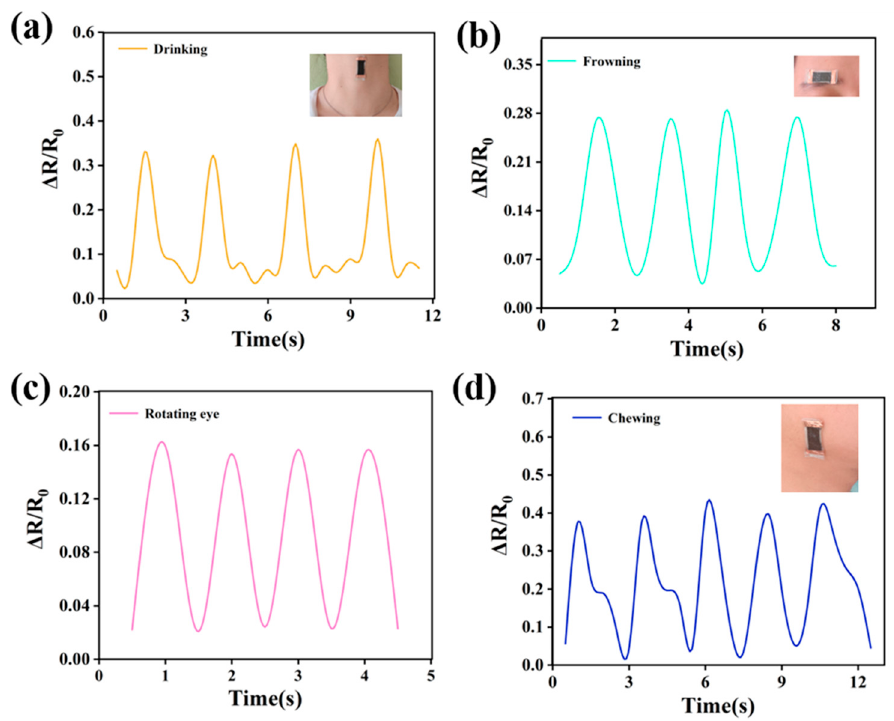
Figure 9. Applications of DEF/c-MWCNTs/PPy sensor in monitoring various subtle human motion: the RRV signal of DEF/c-MWCNTs/PPy warp sensor in monitoring ( a ) drinking and ( b ) frowning. The RRV signal of DEF/c-MWCNTs/PPy weft sensor in monitoring ( c ) eye movements and ( d ) facial muscle movements.